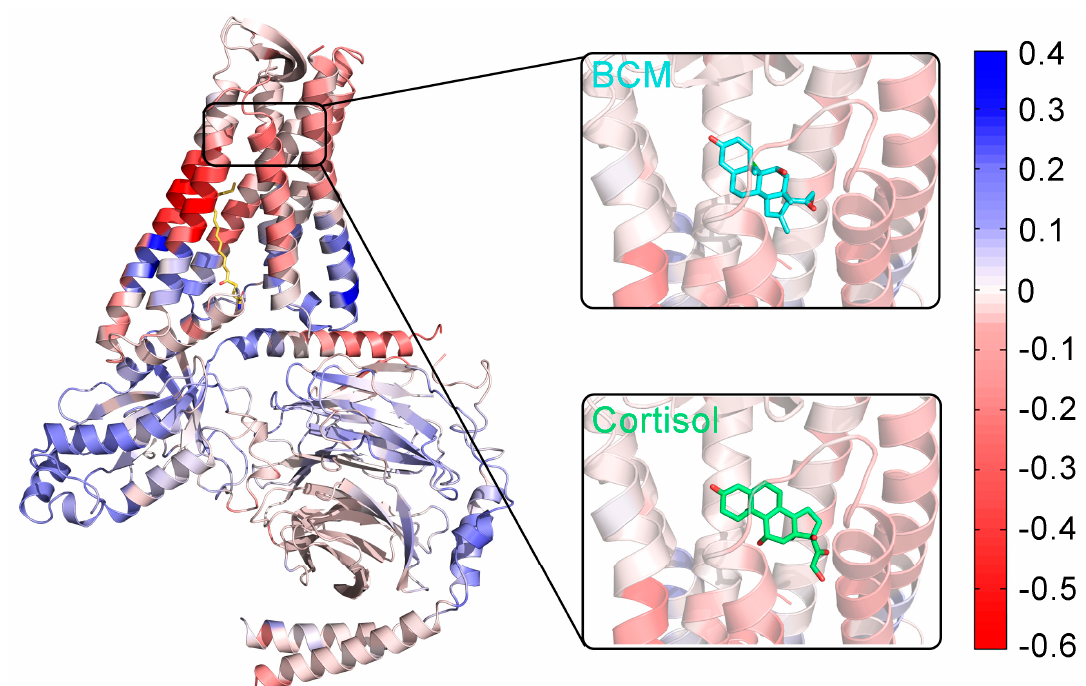
Figure 7. The allosteric effects of palmitoylation at the G o C-tail on GPR97, calculated by AlloSigMA. GPR97 is colored according to per-residue allosteric free energy values ( ∆ gi). The unit of free energy values is kcal/mol on the right-hand side of the color map.